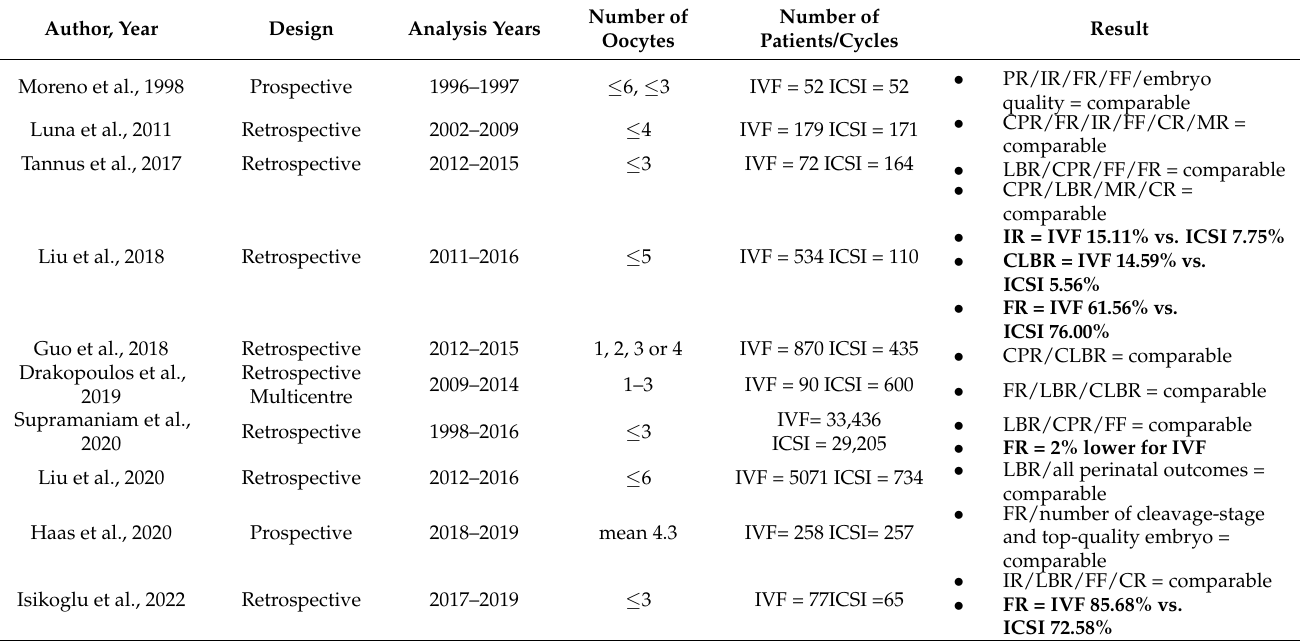
Table 2. Studies comparing c-IVF and ICSI outcomes in women with DOR in the absence of male factor